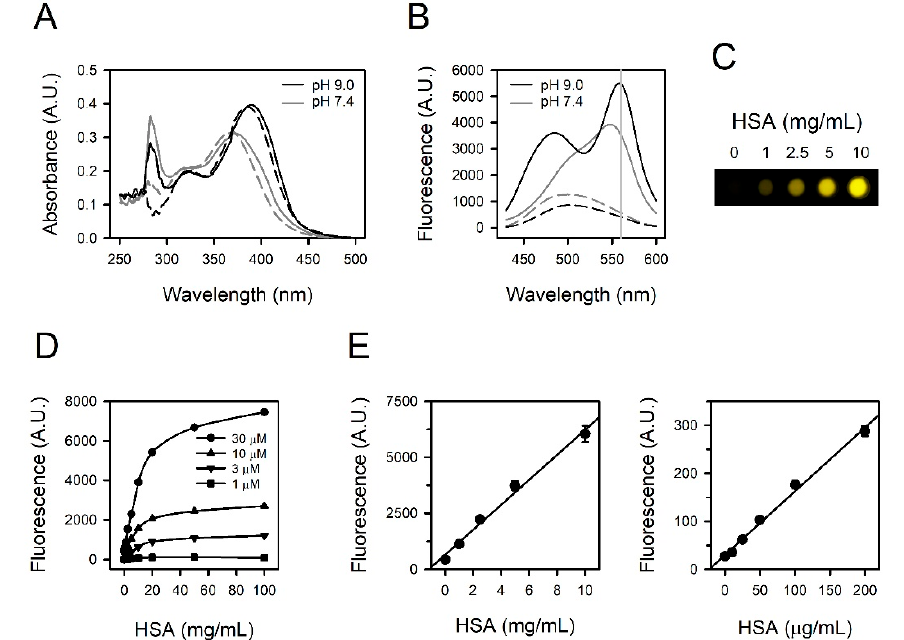
Figure 1. Fluorescence spectra and titration curves obtained from fisetin and HSA. ( A ) The absorbance spectra and ( B ) the emission spectra from excitation at 400 nm were obtained from 30 µ M fisetin at pH 7.4 (gray lines) or pH 9.0 (black lines) in the presence (solid lines) or absence (dashed lines) of 5 mg / mL HSA. A gray vertical reference line was drawn at 560 nm ( B ). ( C ) The fluorescence image of HSA-containing fisetin solutions was obtained at excitation at 400 nm. ( D ) The titration curves were acquired with 0–30 µ M fisetin and 0–100 mg / mL HSA. ( E) The standard curves were prepared with 30 µ M fisetin and 0–10 mg / mL HSA (left panel) or 1 µ M fisetin and 0–200 µ g / mL HSA (right panel). The values are presented as means ± standard errors ( n =